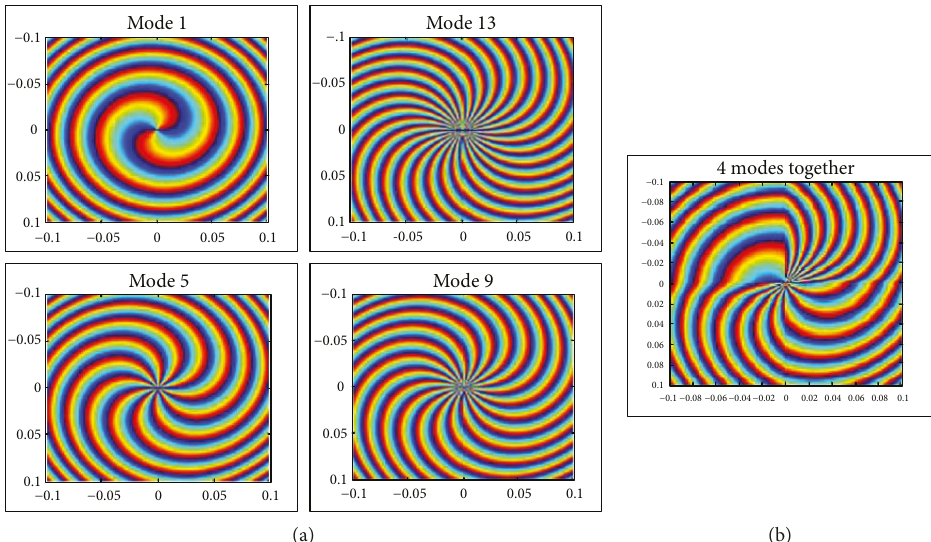
Figure 10: (a) Conventional receiver with four complete matching spiral-phase patterns for modes (1, 5, 9, and 13) versus the combined 4- quarter matching partial patterns in the simple receiver in Figure